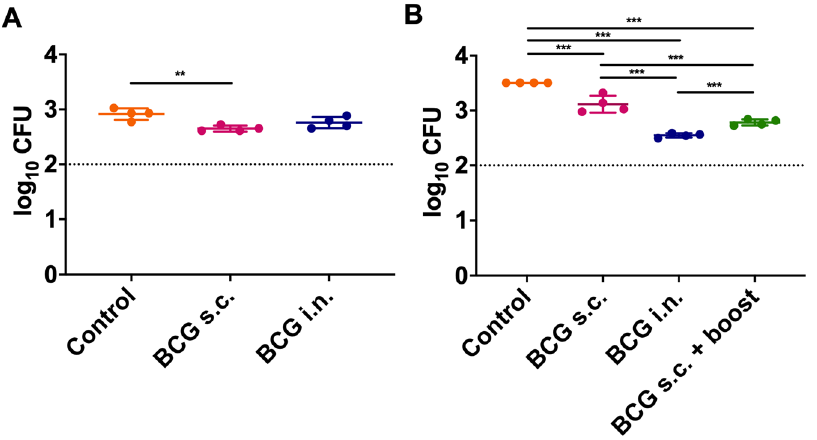
Figure 1. Host-cell density affects growth inhibition in the ex vivo MGIA. C57BL/6 mice (n = 6/group) received s.c. or i.n. BCG Pasteur Aeras at week 0 or no treatment (control). An additional group shown in part B received s.c. BCG Pasteur Aeras at week 0 followed by i.n. boosting with the candidate vaccine spore-FP1 at week 3. At six weeks, ( A ) 3 × 10 6 or ( B ) 1 × 10 6 lung cells were co-cultured with 100 CFU BCG Pasteur Aeras in 48-well plates. At 96 hours, samples were lysed and transferred to the BACTEC system until TTP values were generated. TTP values were converted to log 10 CFU based on a standard curve. Data points (n = 4/group) represent samples generated from pooled cells isolated from six mice. Dotted line indicates mycobacterial input at day 0. Statistical significance was tested by one-way ANOVA followed by Tukey’s multiple comparison test. Error bars represent mean ± standard deviation. ** p < 0.01 (adjusted); *** p < 0.001 (adjusted). ANOVA, analysis of variance; BCG, Bacille Calmette-Guérin; CFU, colony-forming units; i.n., intranasal; MGIA, mycobacterial growth inhibition assay; s.c., subcutaneous; TTP, time to